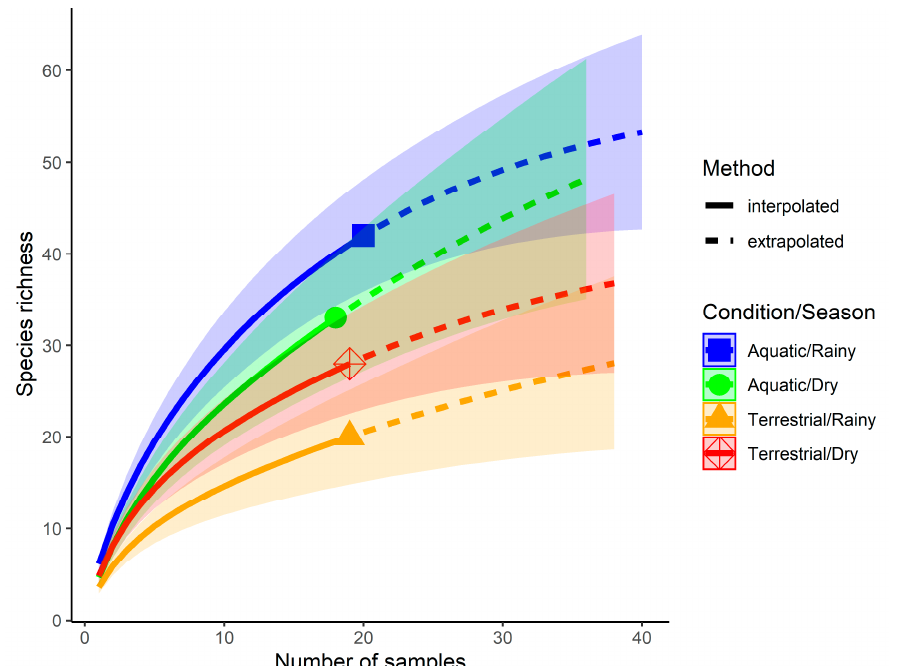
Figure 3. The sample-size-based rarefaction curves showing interpolated (continuous lines) and extrapolated (dashed lines) AMF species richness in aquatic/terrestrial and rainy/dry season conditions. The shaded areas represent a 95% confidence interval obtained using a bootstrap method based on 999 replications.